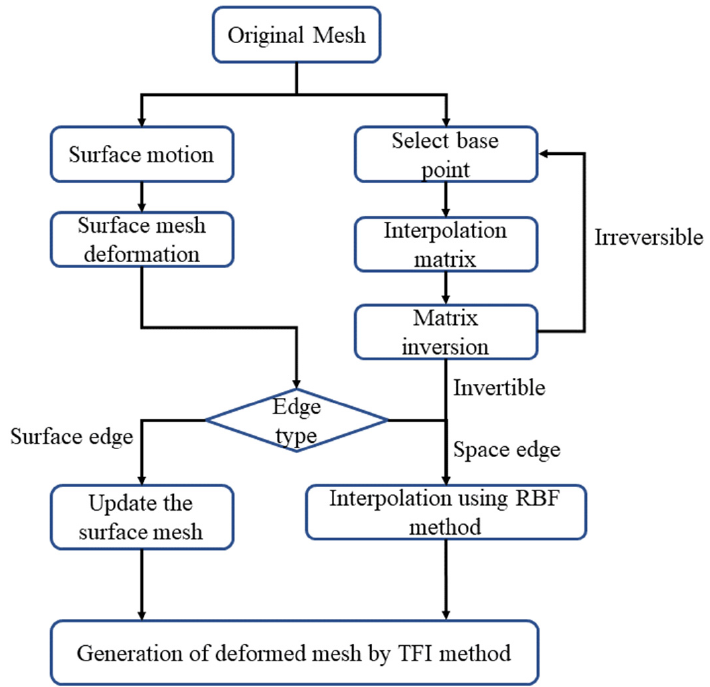
the radial basis point. The corner selection algorithm first selects the corners of the attribute surface grid, then calls the lookup module to remove the repeated corners, and selects other surface grid points as the remaining radial basis points through the greedy algorithm.